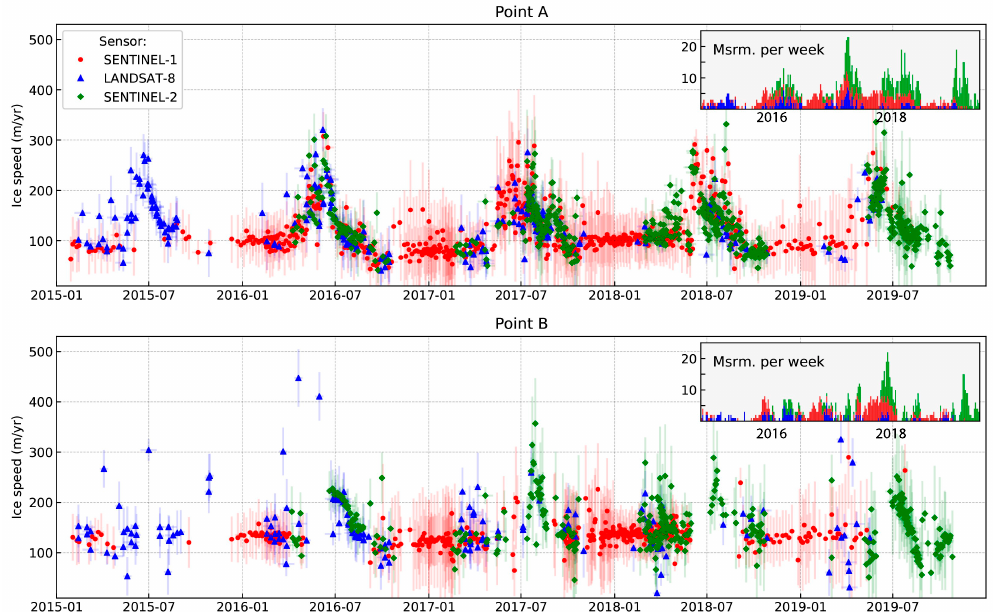
Figure 4. Velocity measurements from Landsat-8 (blue), Sentinel-2 (green), and Sentinel-1 (red) for 2 different locations (67.099 ◦ N, 49.953 ◦ W and 67.134 ◦ N, 49.177 ◦ W) as indicated by red stars in Figure 1. Vertical bars correspond to the estimated errors and horizontal bars correspond to the time-span between master and slave images used for tracking the displacement. Sub-plots show the number of available measurements per week; colors and temporal extent ( x -axis) are the same as the main